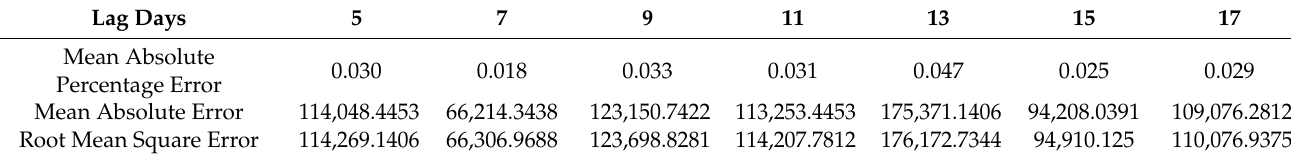
Table 1. Evaluation of different time windows on the prediction performance.